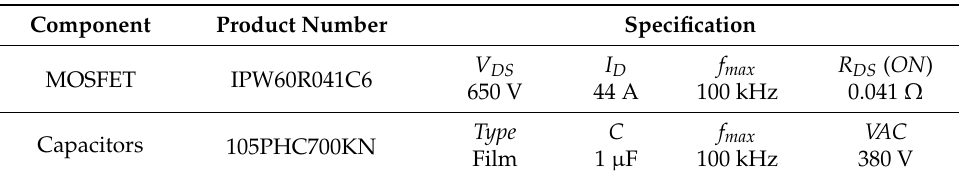
Table 3. Selected Electronic